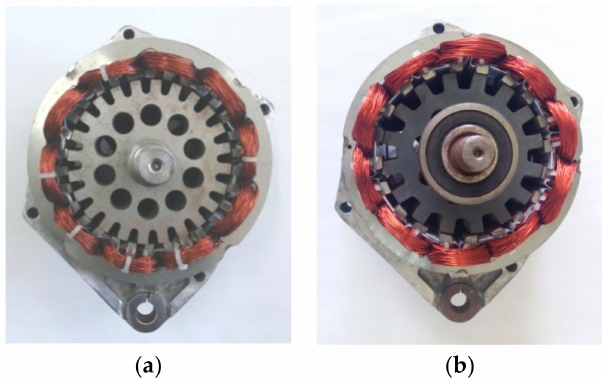
Figure 5. The rotor and stator of the five-phase WFDSGs. ( a ) 30 / 24-pole; ( b ) 20 / 16-pole.